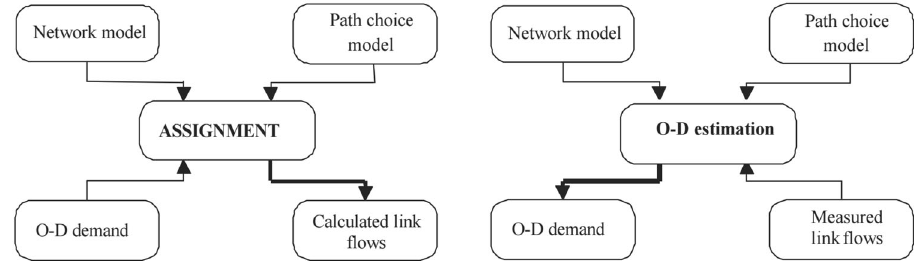
Fig. 13 Relationship between estimation of O–D flows with traffic counts and traffic assignment